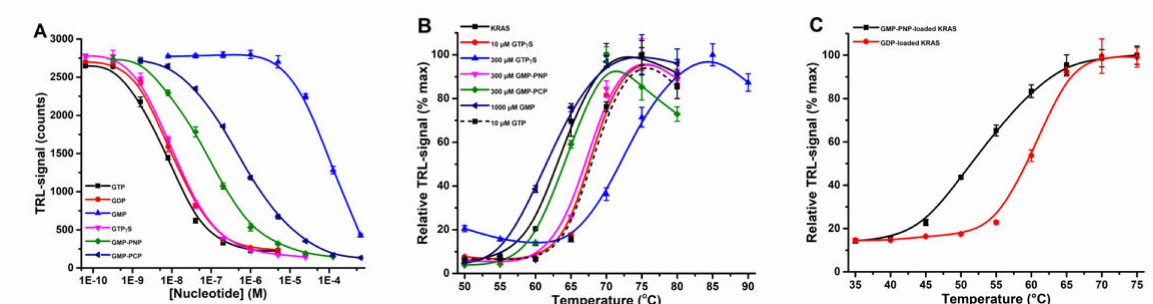
Figure 3. KRAS stabilization by additional nucleotides is affinity dependent. ( A ) The binding affinity order for nucleotide binding to KRAS (15 nM) was determined by QRET nucleotide exchange assay in a SOS cat (10 nM) induced reaction. KRAS binding for GTP (black), GDP (red), and GTP γ S (magenta) was <15 nM, while GMP-PNP (green) and GMP-PCP (navy) bound at micromolar and GMP (blue) only at millimolar levels. ( B ) KRAS (50 nM) nucleotide-dependent thermal stabilization was affinity- and concentration-dependent as assayed with the Protein-Probe. KRAS WT (solid black) was similarly stabilized by 10 µ M GTP (dashed black) and 10 µ M GTP γ S (red). At 300 µ M concentration, GTP γ S (blue) showed the highest stabilization, followed by GMP-PNP (magenta) and GMP-PCP (green). GMP (navy) showed no KRAS stabilization. ( C ) Thermal stability using preloaded KRAS (50 nM) was in agreement with solution-based binding using an excess of nucleotides. KRAS-GDP WT (red) was thermally significantly more stable than KRAS-GMP-PNP WT (black). Data represent mean ± SD ( n =